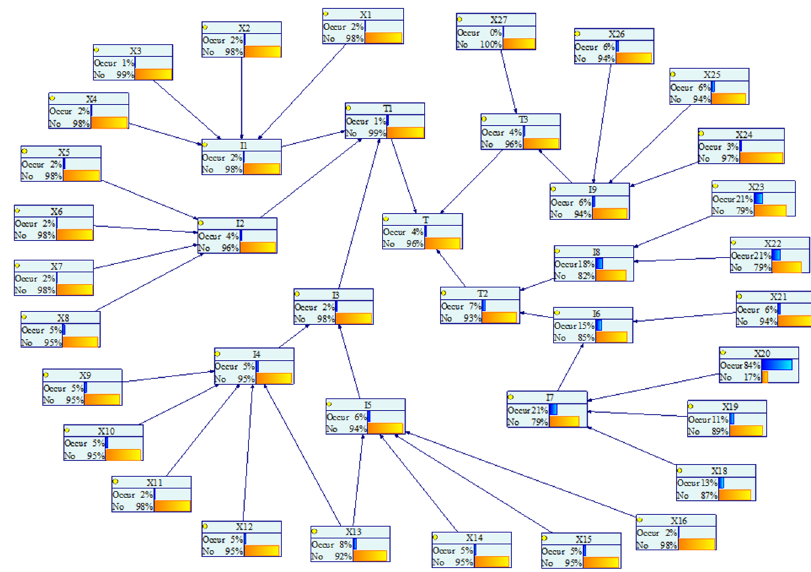
Figure 10. The prior probability of each node in the BN of the coal gasifier.